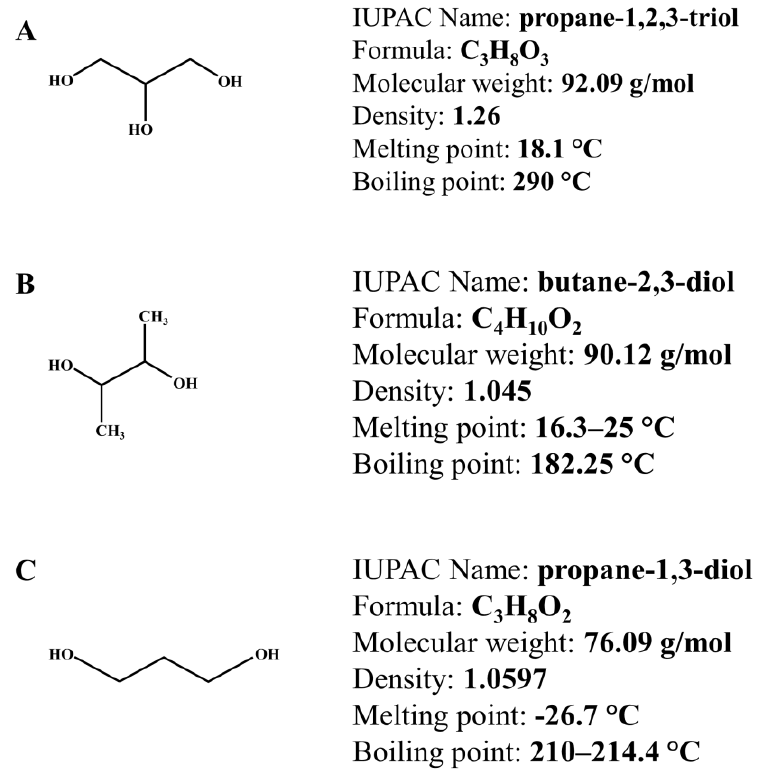
Figure 1. The chemical structure and properties for ( A ) (glycerol), ( B ) (2,3-butanediol), and ( C ) (1,3-propanediol).